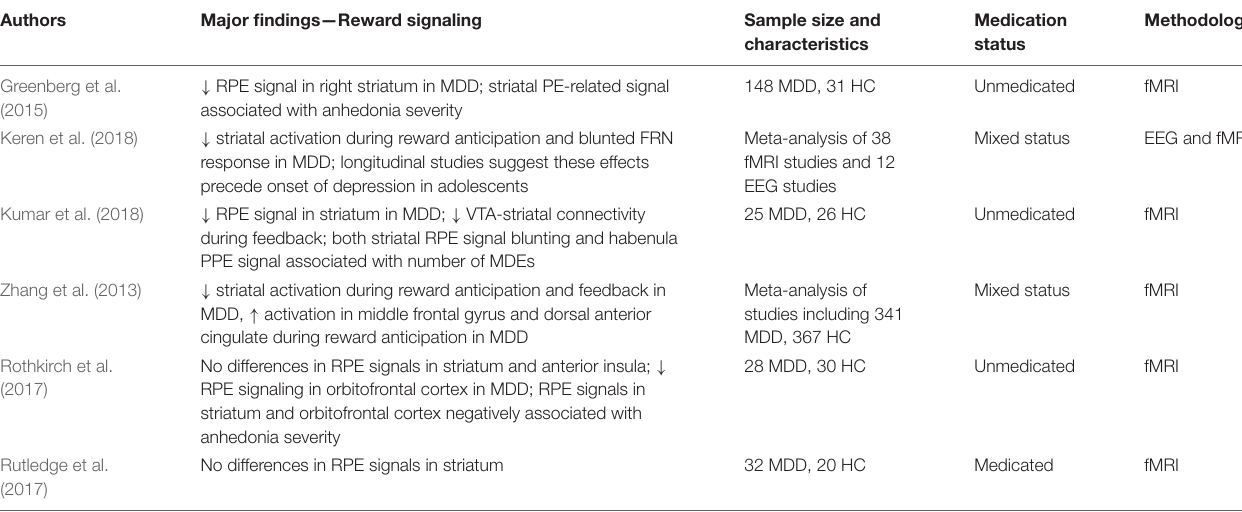
TABLE 2 | Reward prediction and prediction error disruptions in MDD. Major findings—Reward